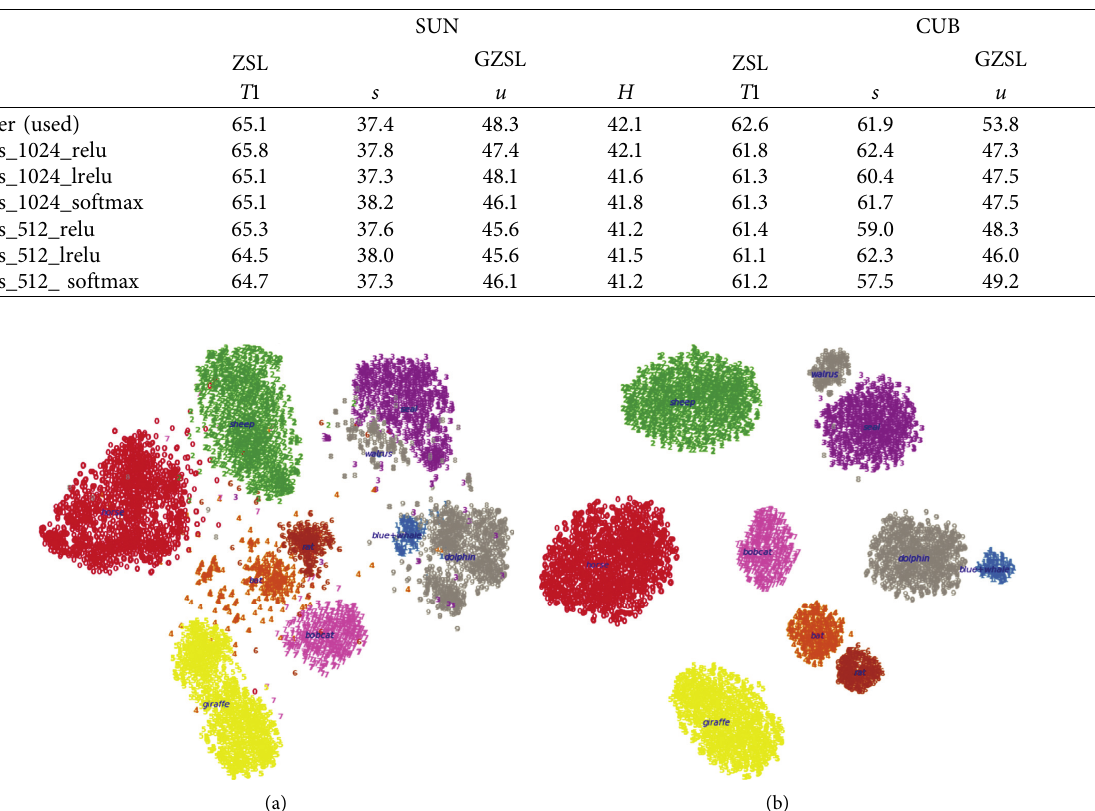
Table 4: The results of different classifiers on SUN and CUB. The single-layer structure is what we use for our proposed model. The two layers mean that a latent layer is added to the single-layer structure, the _relu/_lrelu/_sigmoid indicates the activation function followed by the hidden layer, and _1024/_512 indicates the number of neurons in the added hidden layer.